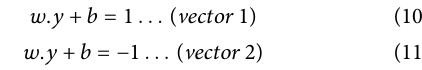
FIGURE 6 Classi fi cation model performance.the confusion matrix of SVM-XGB